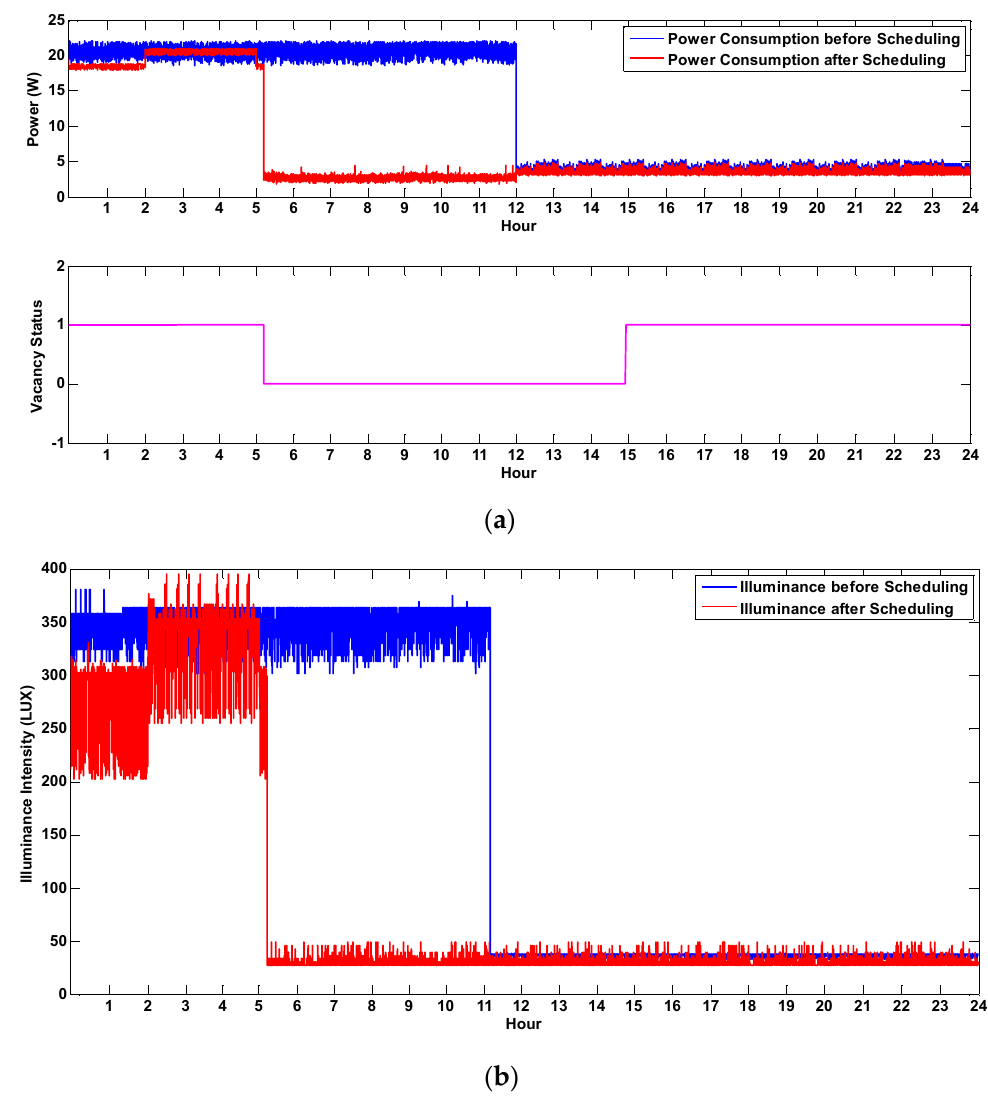
Figure 17. ( a ) Power consumptions of the LED light, room occupancy status and ( b ) illuminance variations without and with the use of the HEM system.